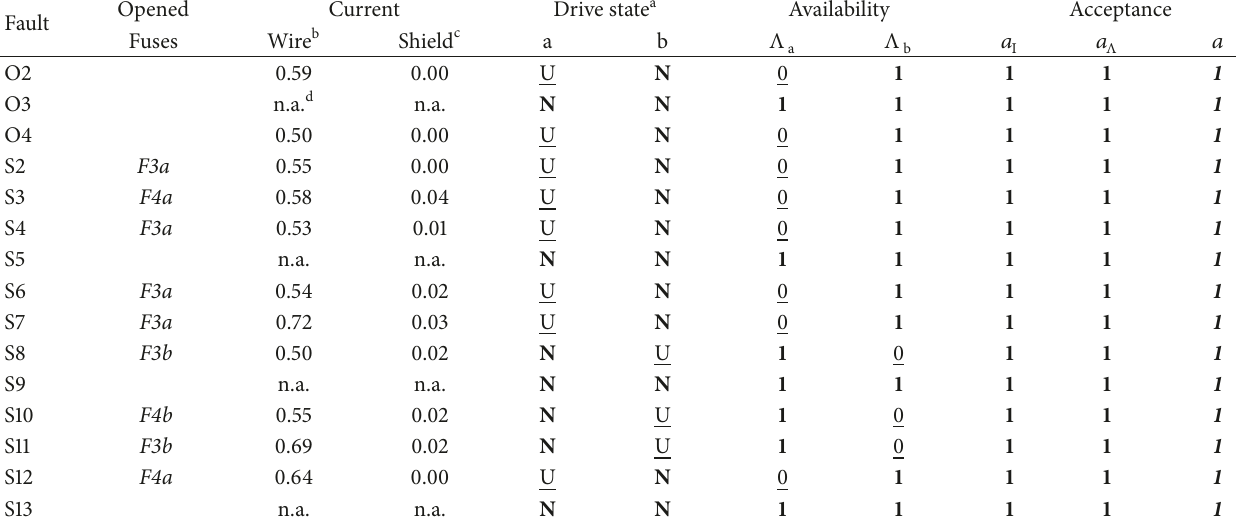
Table 6: Experimental